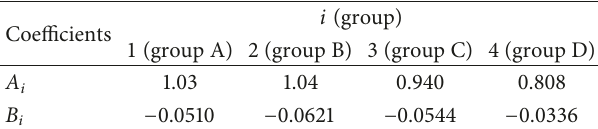
Table 4: Coefficients A